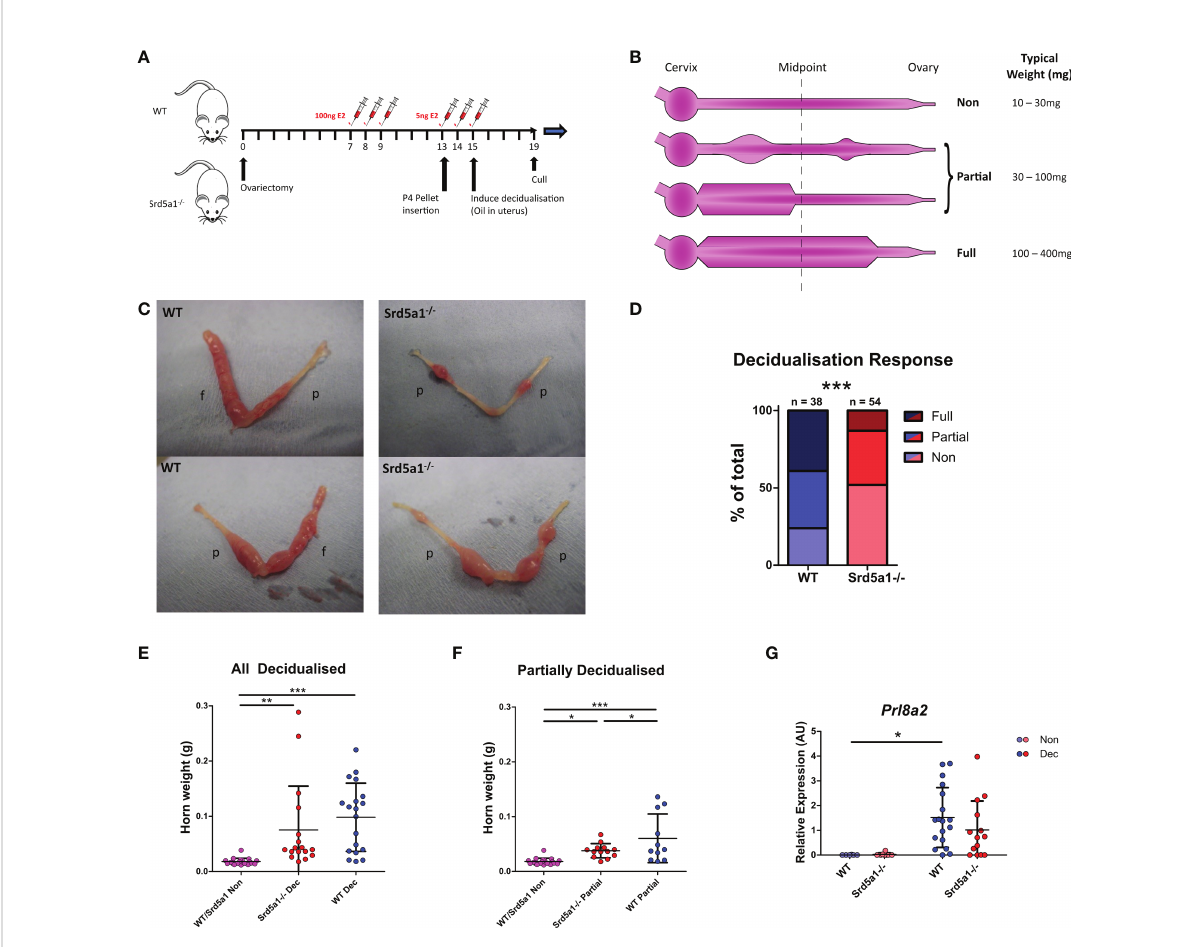
FIGURE 1 Decidualization response is impaired in Srd5a1 -/- mice. (A) Schema for the decidualization induction model. E2 = estradiol. P4 = progesterone. (B) Graphic depicting a uterine horn in various stages of decidualization. The horn is thicker where a decidualization reaction has occurred. A horn is deemed fully decidualized if an uninterrupted stretch of decidualization has occurred over at least half of the horn length. Partial decidualization is any decidualization response less than this, often occurring as disparate nodes along the horn. (C) Representative images of uterine horns from wild type (WT) and Srd5a1 -/- animals, with the classi fi cation of each horn given; p = partial decidualization, f = fully decidualized. (D) Contingency table depicting proportion of horn responses in each genotype. (E, F) Wet weight of uterine horns in WT and Srd5a1 -/- mice at time of tissue recovery (4 days following decidualization induction). Non-decidualized horns have been pooled. E compares all horns with a decidualization reaction (Full & Partial), whereas F shows analysis of those with a partial reaction. (G) Expression of Prl8a2 via qPCR in uterine horns of WT and Srd5a1 - / - mice following decidualization induction. Plots in D analyzed by chi-squared test for trend; (E, F) analyzed by one-way ANOVA with Newman-Keuls post-hoc tests; and G analyzed by two-way ANOVA with Bonferroni post-hoc tests; ***p < 0.001; **p < 0.01; *p <